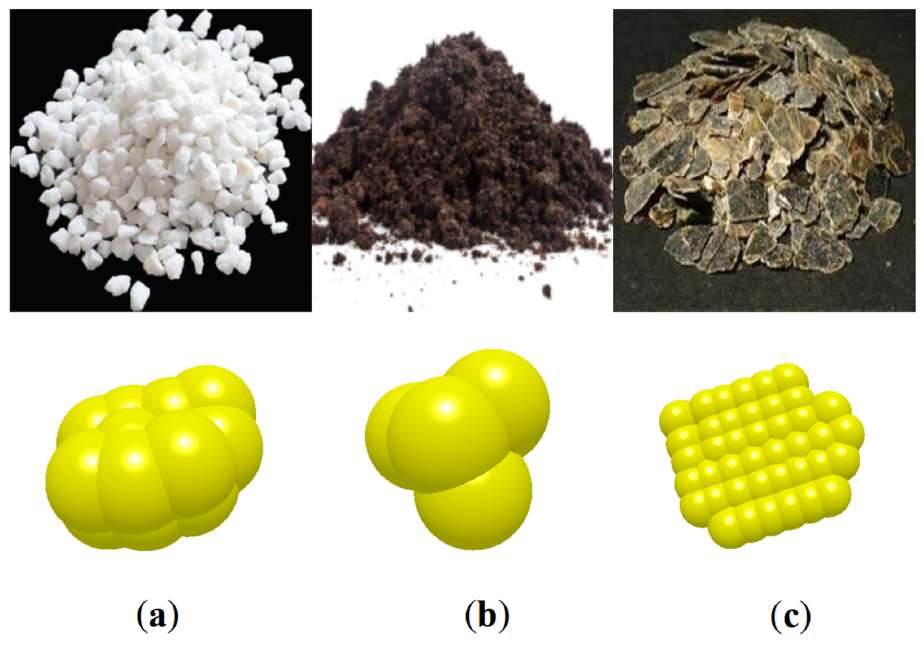
Figure 4. Particle models of growing substrate: ( a ) is peat particle model, ( b ) is perlite particle model, and ( c ) is vermiculite particle